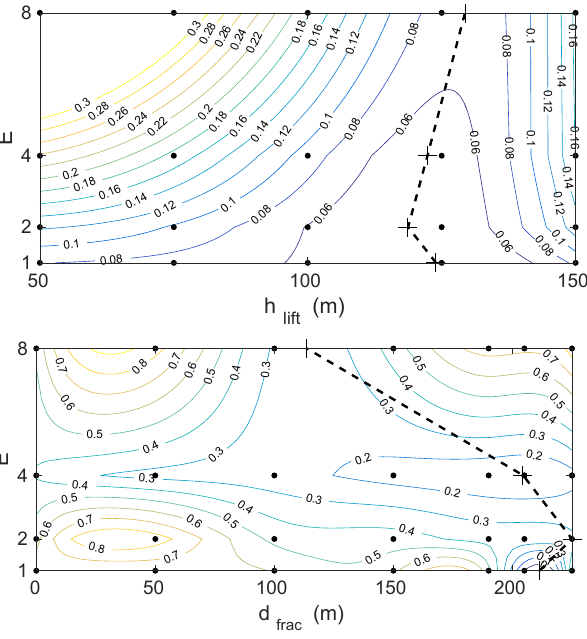
Figure 5. Level sets of the absolute misfit (in m per day) between modelled and measured surface velocity magnitudes as a function of the enhancement factors E ( y axis) and h lift and d frac ( x axis), respectively. Here, we used a constant parameter α = 1, and C was tuned to measured surface velocities in the extended model domain. The symbols have the same meaning as in Fig.